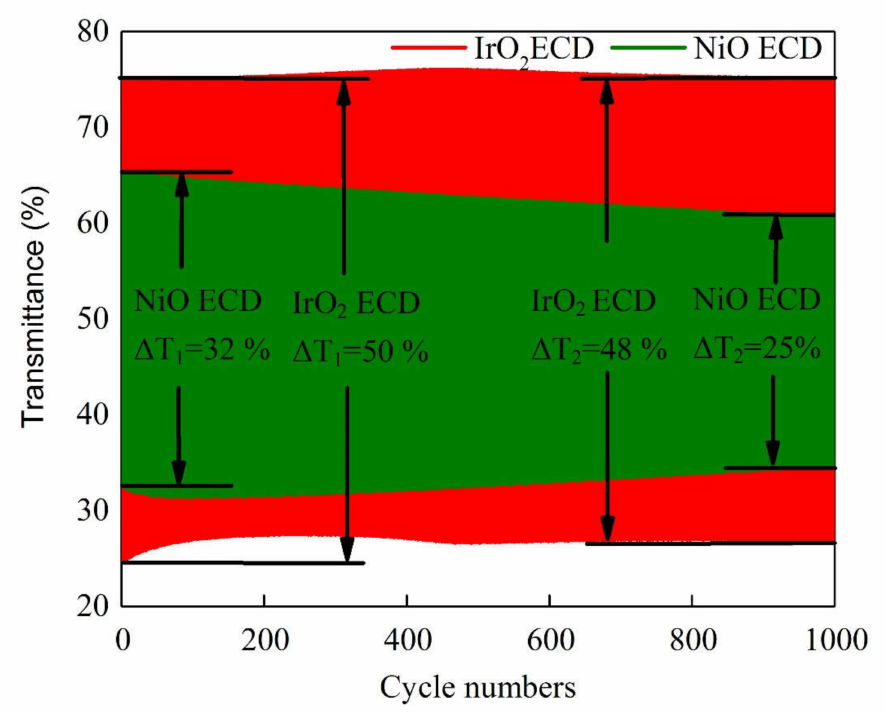
Figure 8. The comparison durability of the electrochromic device (ECD) is evaluated by optical transmittance modulation at 633 nm during 1000